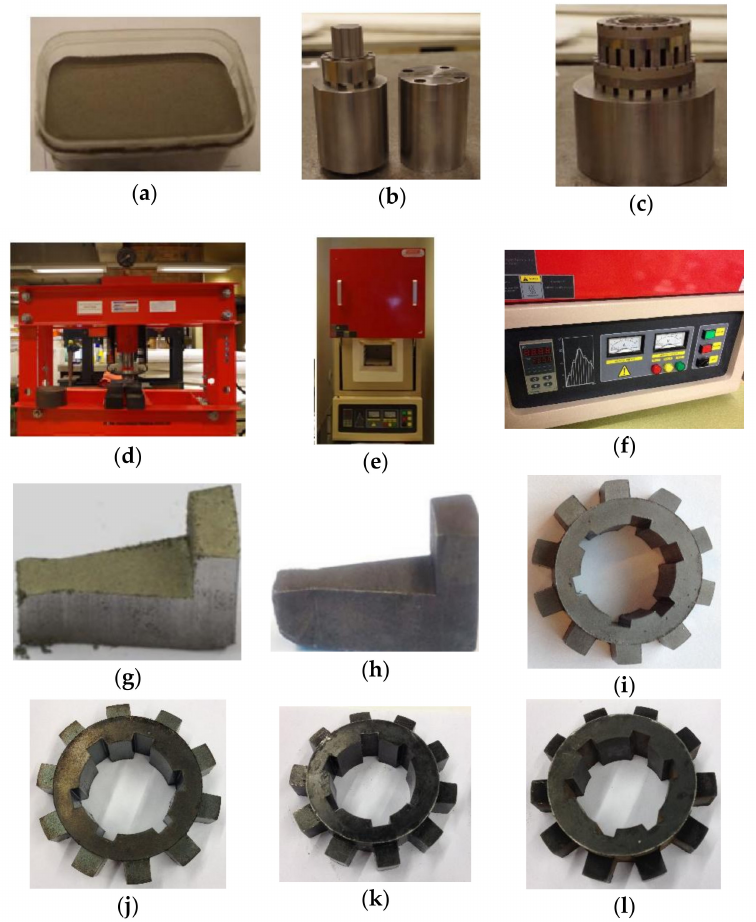
Figure 3. Facilities and SMC cores for the proposed FSPMM, ( a ) SMC powder, ( b ) die tools for compaction of the rotor core, ( c ) die tools for compaction of the stator cores, ( d ) a hydraulic press, ( e ) a high-temperature furnace, ( f ) the temperature control panel, ( g ) a raw stator core, ( h ) a cooked stator core after heat treatment, ( i ) a raw stator core, ( j – l ) three stator cores after heat